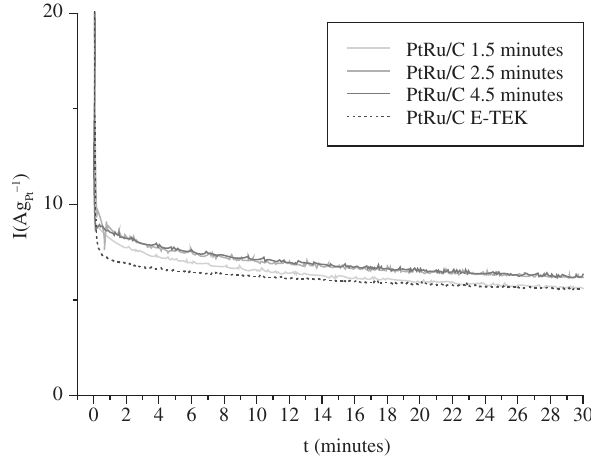
Figure 4. Current-time curves at 0.5 V for different electrocatalysts in 1.0 mol.L –1 methanol in 0.5 mol.L –1 H